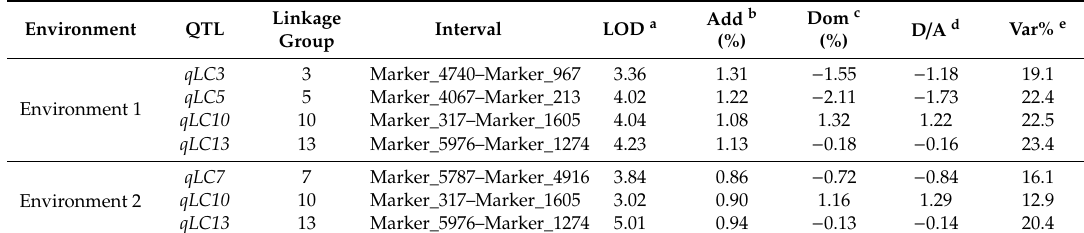
Table 2. Quantitative trait loci (QTLs) identified for the trait of fiber lignin content from ZSZ1 / BNT populations in two